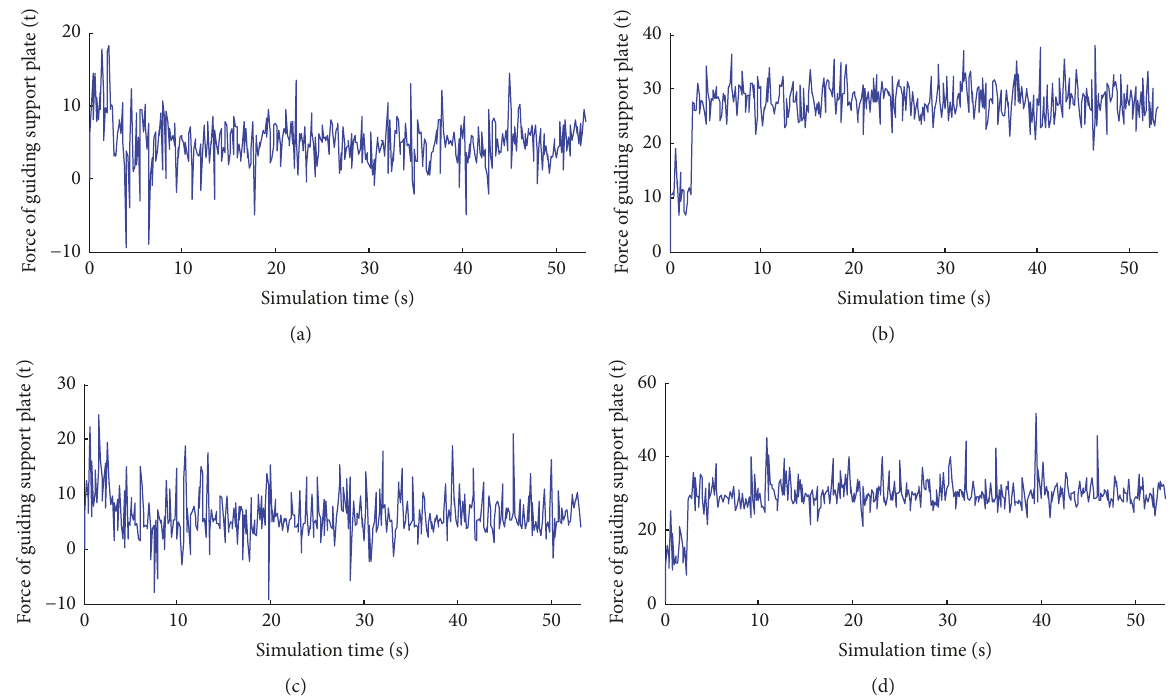
Figure 4: Time histories of forces acting on guiding support plate pin shafts. (a) Force along the 𝑌 direction on the left guiding support plate pin shaft, (b) force along the 𝑍 direction on the left guiding support plate pin shaft, (c) force along the 𝑌 direction on the right guiding support plate pin shaft, and (d) force along the 𝑍 direction on the right guiding support plate pin shaft.